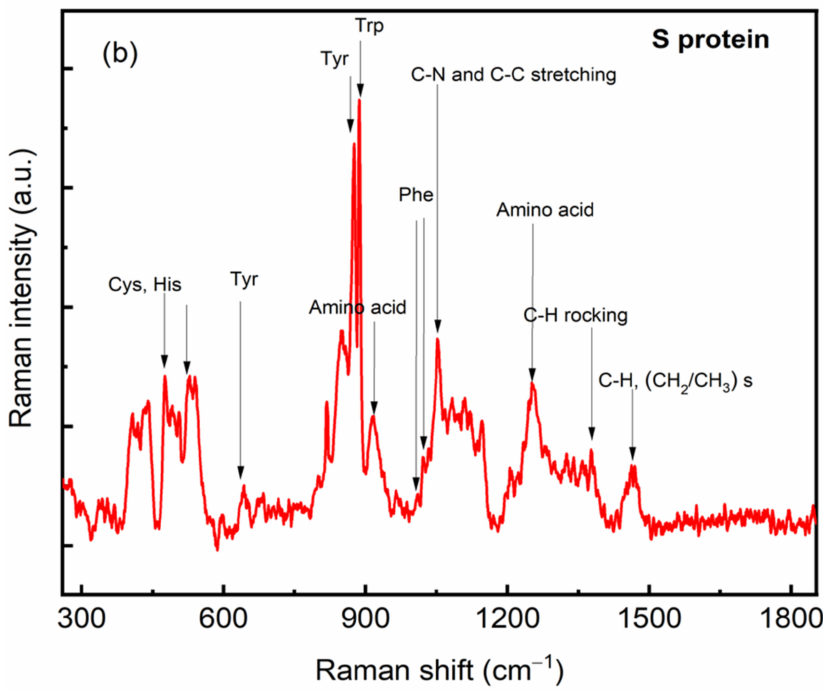
Figure 4. Far-field Raman spectra of ( a ) RBD, and ( b ) S. For both proteins, the most relevant vibrational bands are cysteine (Cys), histidine (His), tyrosine (Tyr), glutamic acid (Glu), tryptophan (Trp), phenylalanine (Phe), C-N and C-C protein stretching, C-H rocking, and C-H stretching of glycoproteins located at 526 cm − 1 , 640 cm − 1 , 876 cm − 1 , 889 cm − 1 , 1005 cm − 1 , 1033 cm − 1 , 1050 cm − 1 , 1377 cm − 1 , and 1460 cm − 1 , respectively. Laser wavelength 632.8 nm, using CaF 2 substrate and 150 s integration